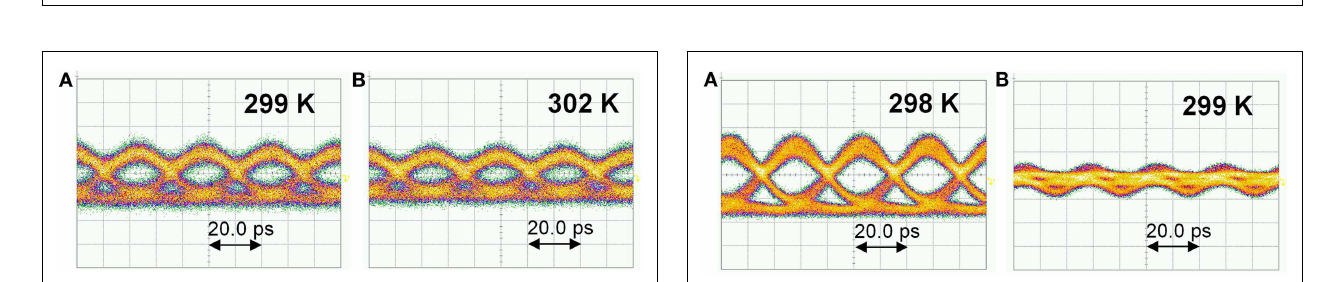
FIGURE 6 | Decoded-signal spectra and eye diagrams (insets) of (A) constructive- and (B) destructive interference at 298K .